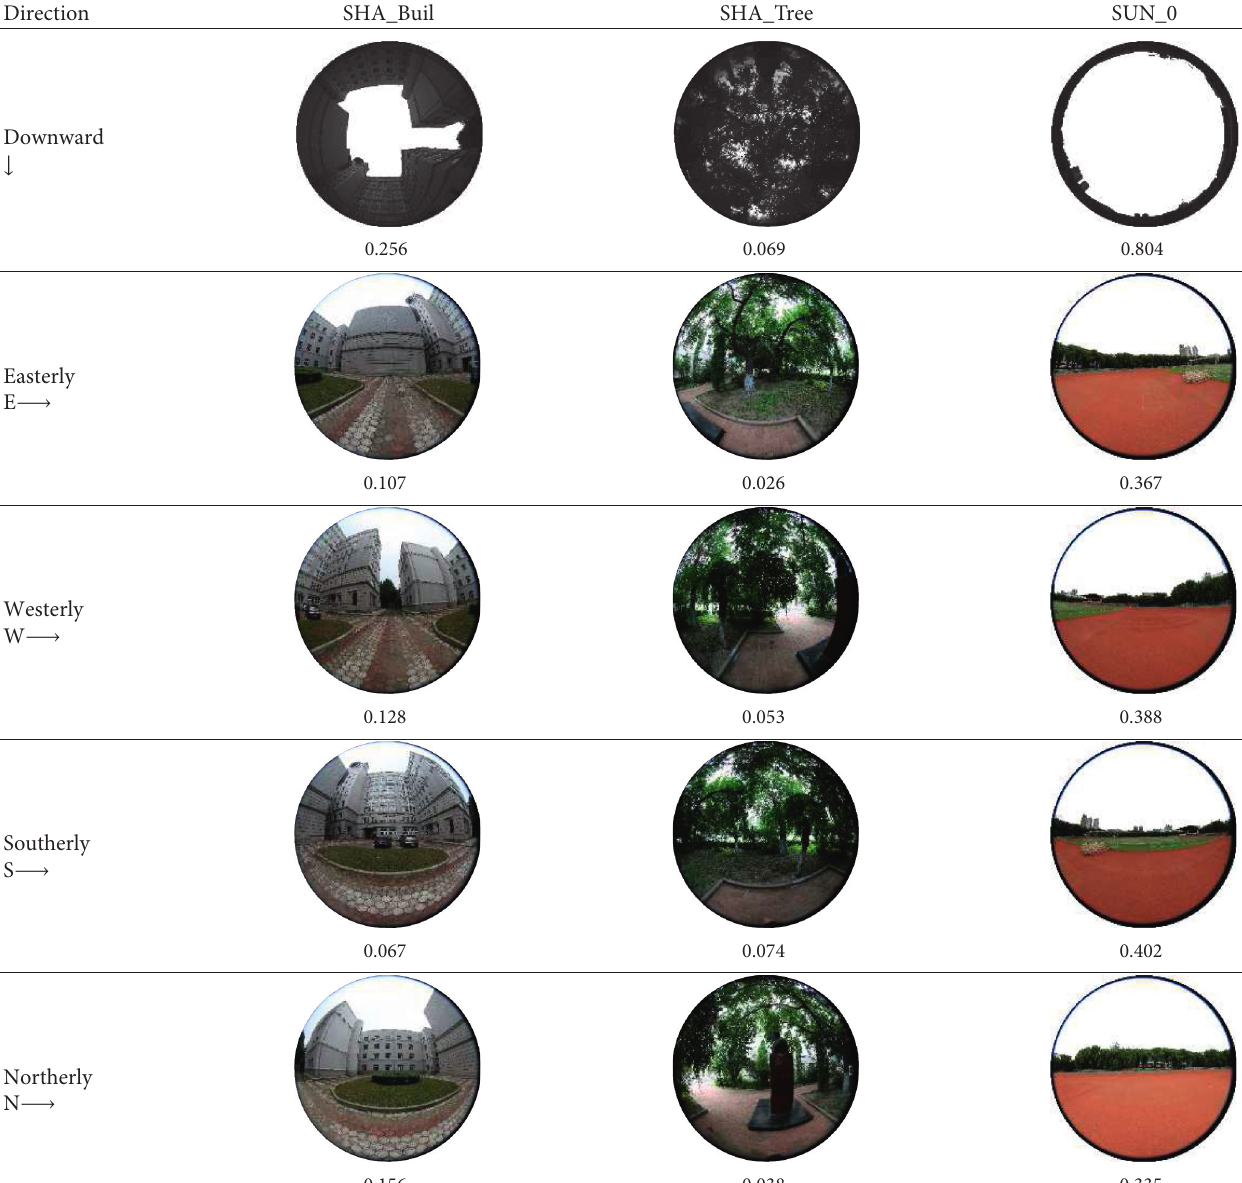
Table 3: Summary of SVF